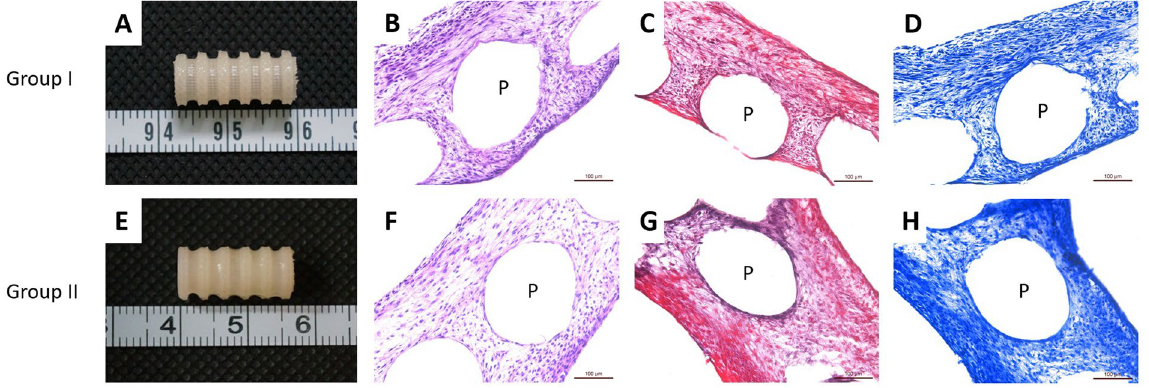
Figure 4. Representative photomacrographs and histological stainings of tissue-engineered tracheas after reconstruction in vitro . ( A – D ) Group I, TET in vitro cultured with chondrocytes for 2 weeks. ( E – H ) Group II, TET in vitro cultured with chondrocytes for 4 weeks. ( A , E ) Gross view of TET. ( B , F ) Histology staining with H&E. ( C , G ) Histology staining with Safranin O. ( D , H ) Histology staining with Toluidine blue. Scale bars: 100 μ m. (P: PCL scaffold bars).